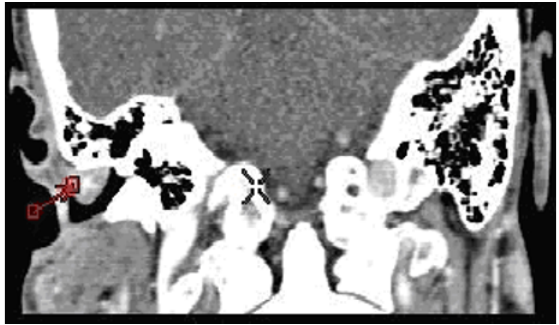
Figure 1. Right temporal bone CT scan with contrast agent showing strong post contrast relatively homogenous high attenuation mass in the External Auditory Canal (EAC).